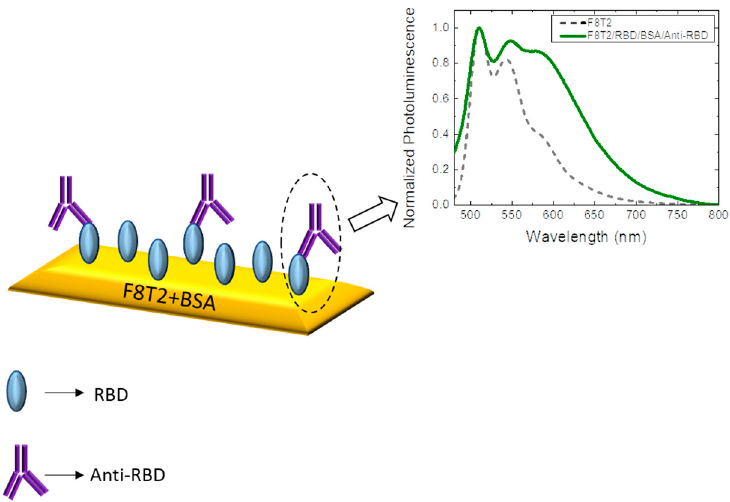
Figure 3. Representation of the RBD/anti-RBD binding generating the alteration of the photolumi- nescence spectrum.